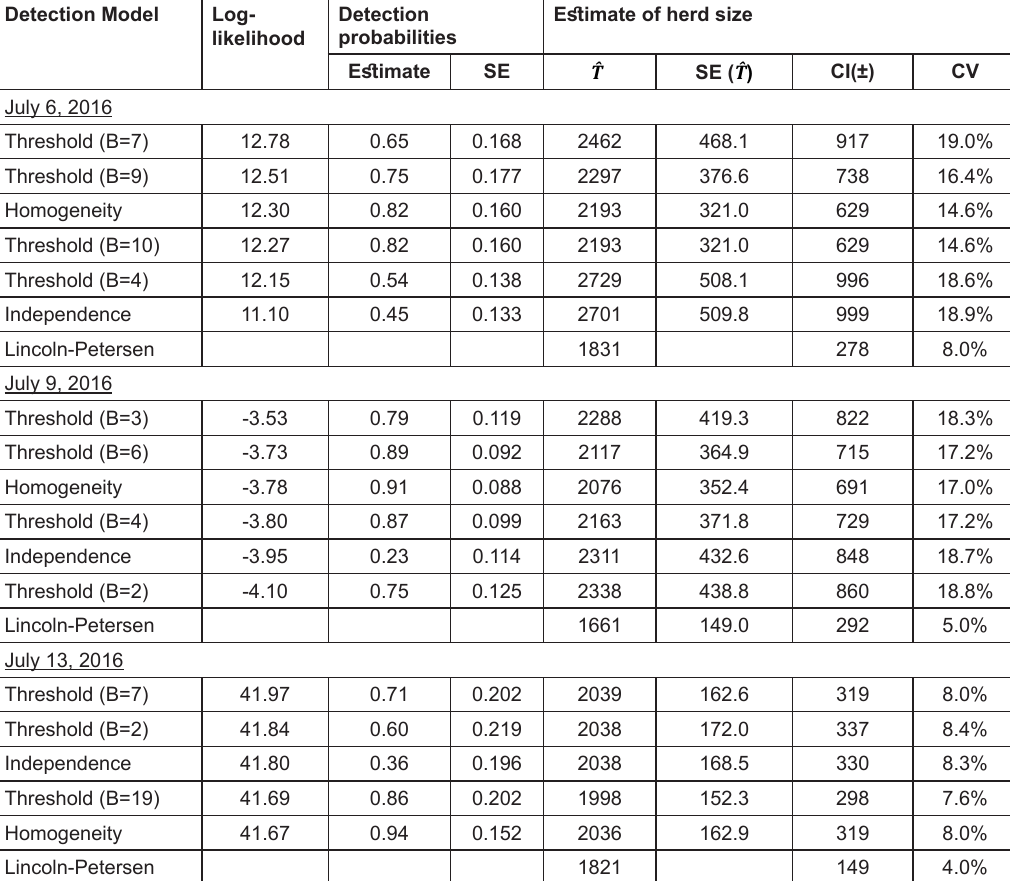
Table 26. Rivest Estimator results and LP estimates for the Cape Bathurst herd July 6, 9, and 13, 2006 data sets. The Lincoln-Petersen estimate is based on Nagy & Johnson (2006).